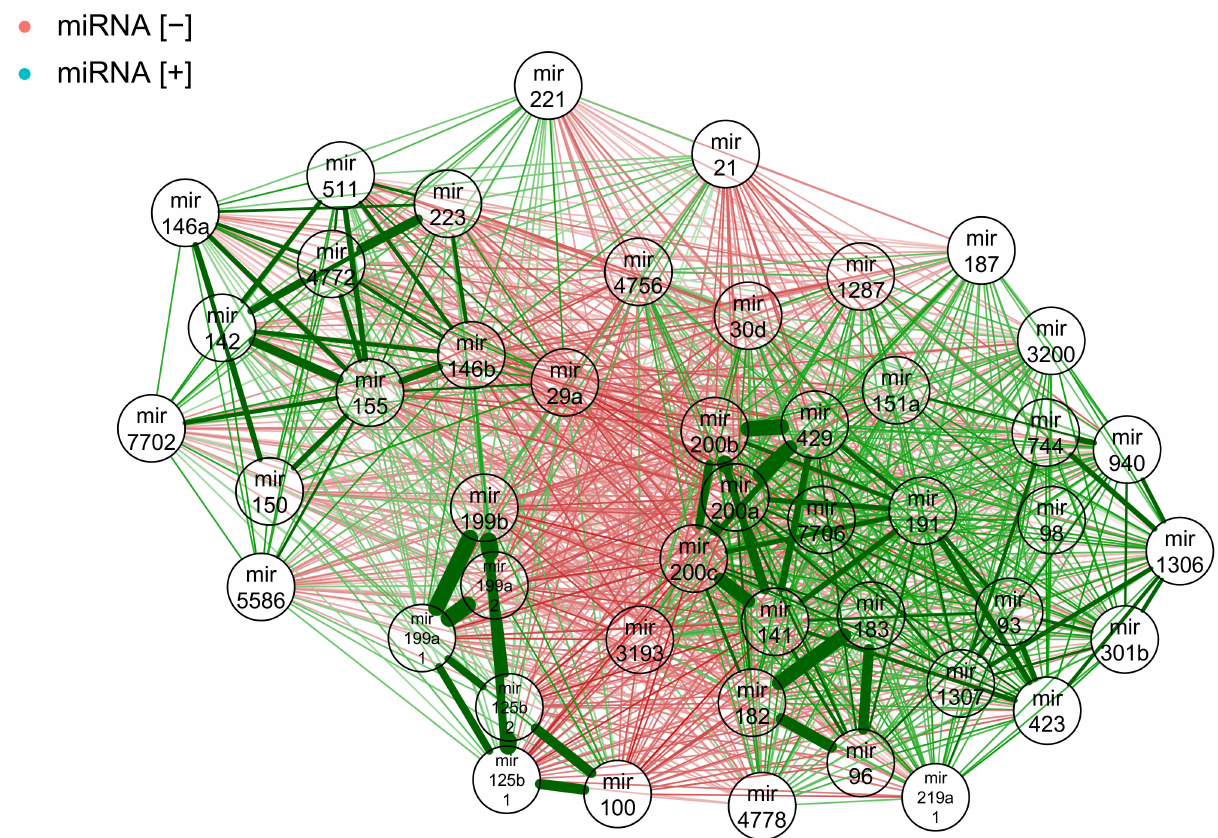
Figure 7. Expression correlation network showing positive (blue negative) and negative (red negative) miRNA hits. Green lines represent positive correlations and red lines represent negative ones. Line thickness represents the strength of the